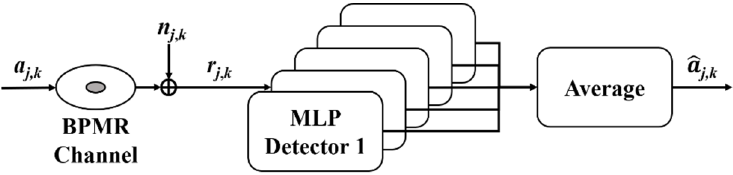
Figure 5. Block diagram of BPMR system with ensemble of MLP detectors.